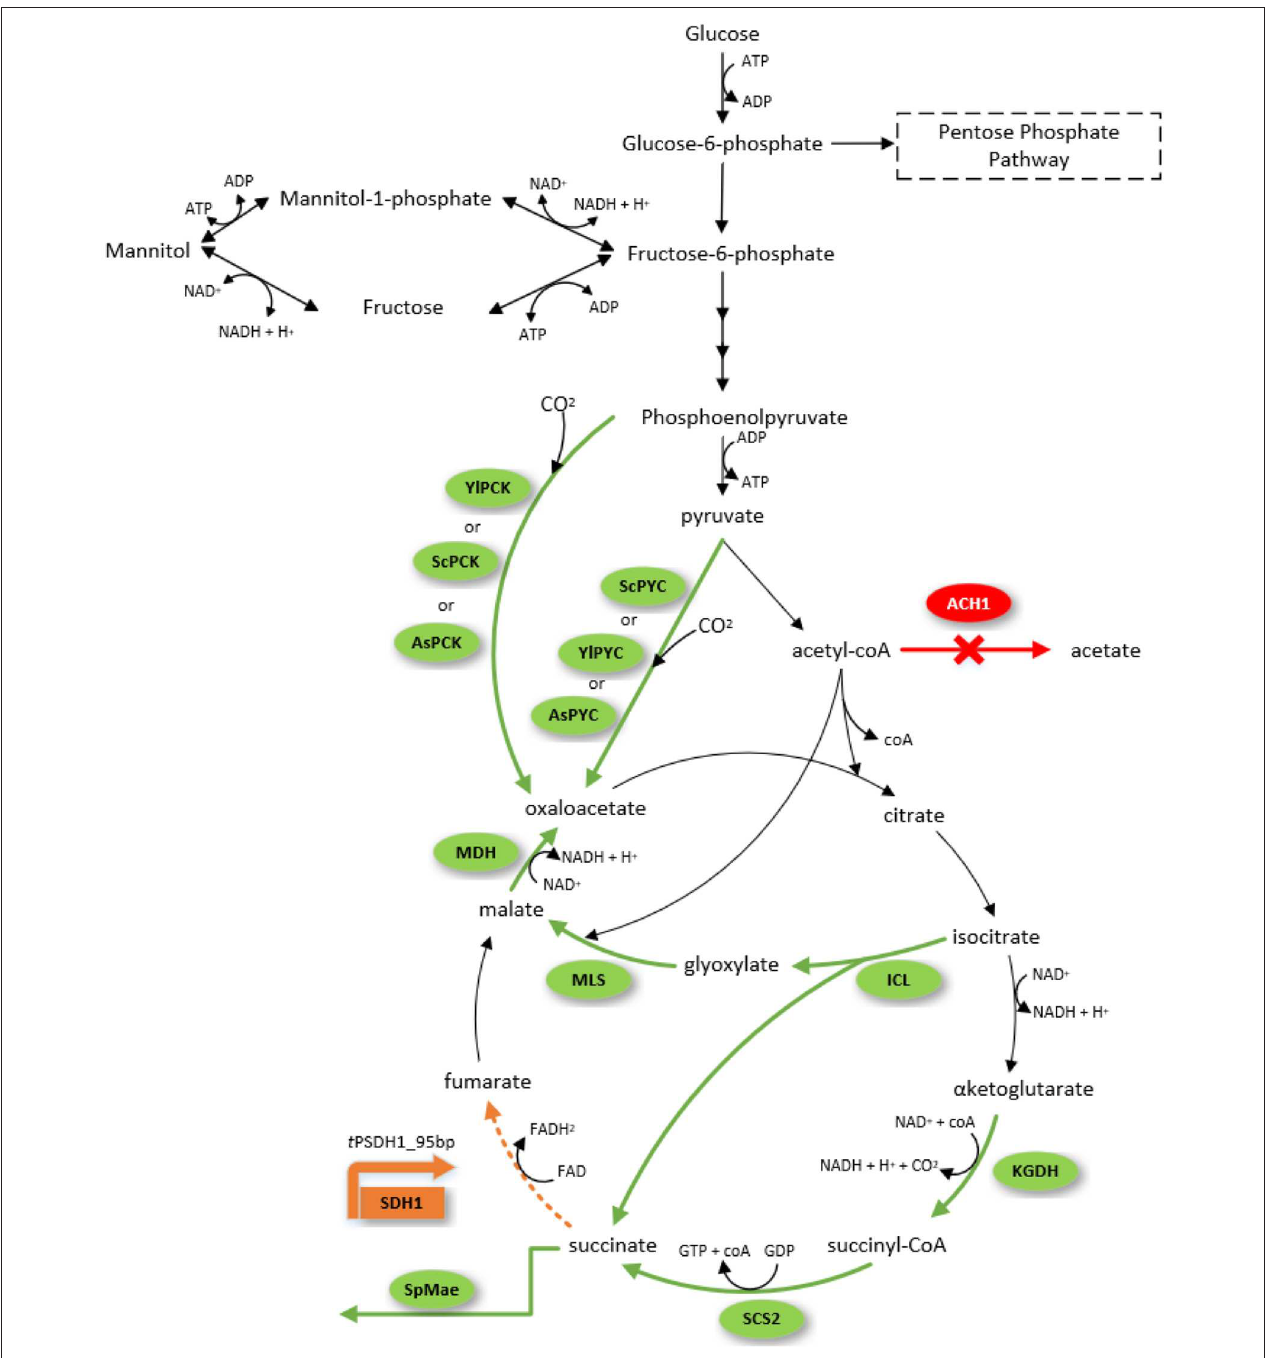
FIGURE 1 | Succinic acid and mannitol biosynthesis pathway from glucose as the sole carbon source in Yarrowia lipolytica. The engineered route for overexpression of genes in this study is highlighted with green arrows, deleted pathways highlighted in red, and downregulated pathway in orange. Gene nomenclature: Acetyl-CoA hydrolase ( ACH1 ), phosphoenolpyruvate carboxykinase from A. succinogenes ( AsPCK ), pyruvate carboxylase from A. succinogenes ( AsPYC ), Isocitrate lyase ( ICL ), α -ketoglutarate dehydrogenase ( KGDH ), malate dehydrogenase ( MDH ), malate synthase ( MLS ), pyruvate carboxylase from S. cerevisiae ( ScPYC ), phosphoenolpyruvate carboxykinase from S. cerevisiae ( ScPCK ), succinyl-CoA synthase beta-subunit ( SCS2 ), dicarboxylic acid transporter from S. pombe ( SpMae1 ), pyruvate carboxylase from Y.lipolytica ( YlPYC ), phosphoenolpyruvate carboxykinase ( YlPCK ), succinate dehydrogenase subunit 1 under the control of truncated promoter ( tPSDH1